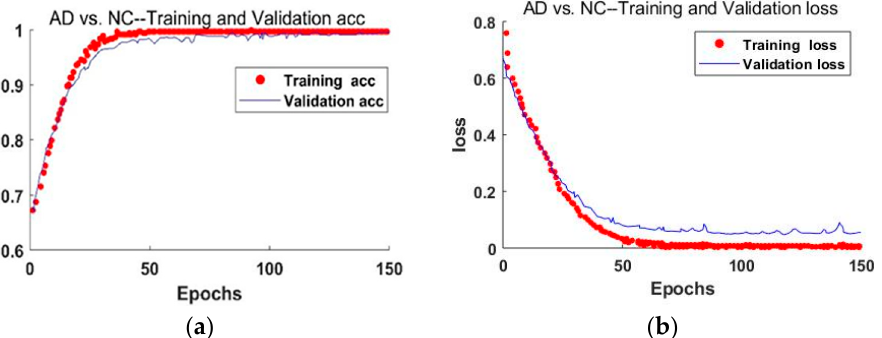
Figure 8. The accuracy and loss curves of the AD and NC classification results. ( a ) The accuracy curve of the improved training network; ( b ) schematic diagram of the loss rate curve of the improved training network.